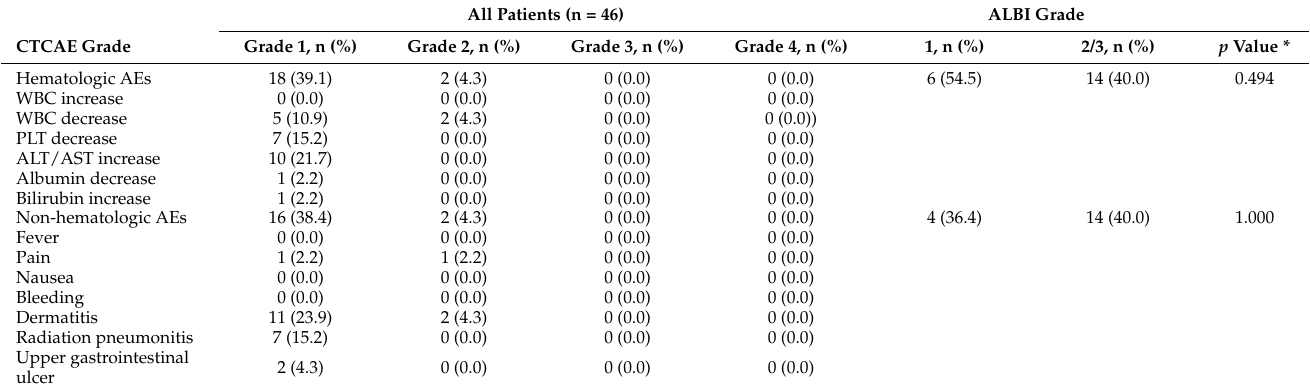
Table 4. Adverse events after proton beam radiotherapy according to albumin-bilirubin (ALBI)